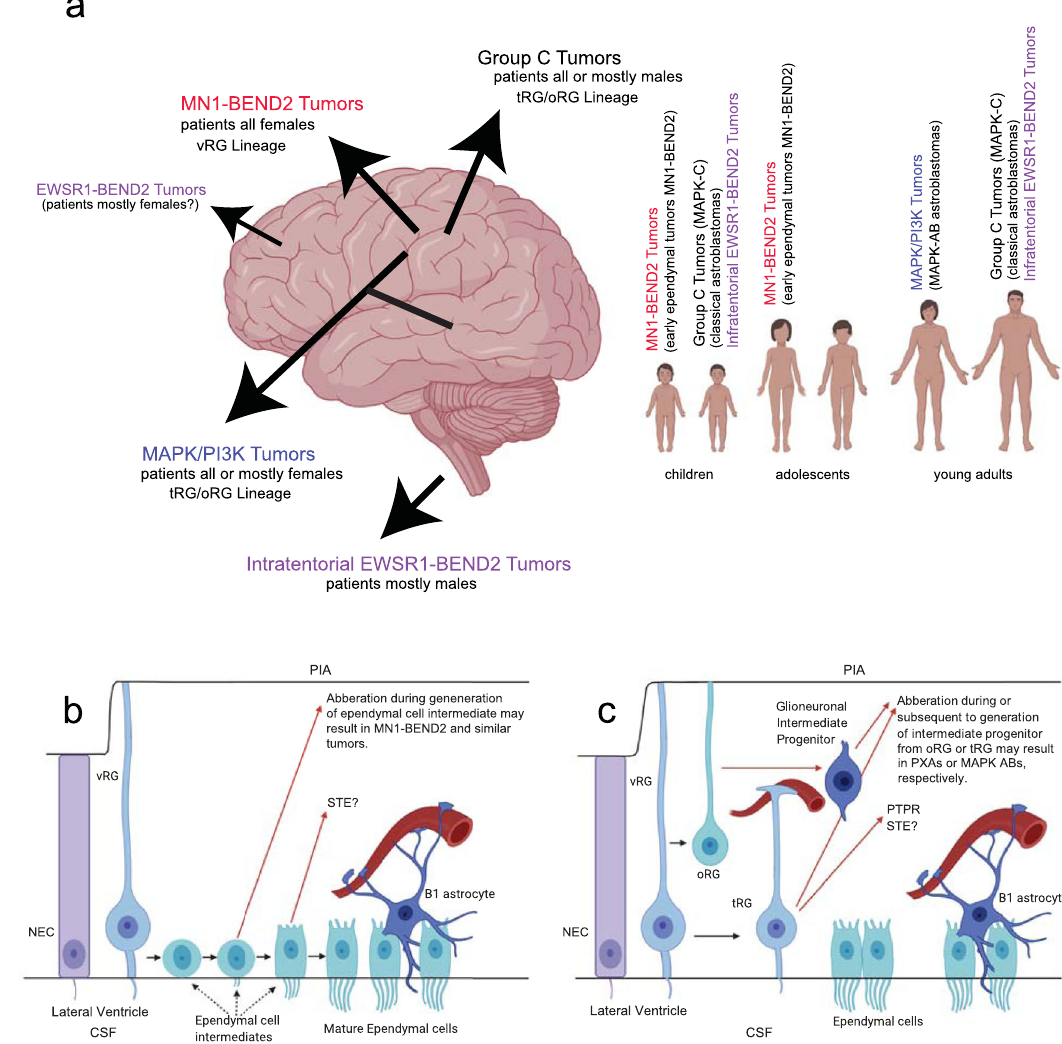
Fig. 8 Astroblastoma-like tumors show neural stem cell type-speci fi c transcriptional lineage of developmentaly early (vRG) to later (oRG and tRG) radial glia and clinically present in comensurate sequencial patient ages. a Summary of anatomic locations and patient age groups of molecular subtypes of AB-like tumors. b Hypothetical model for EET MN1-BEND2 tumorigenesis. c Hypothetical model for MAPK-ABC astroblastoma tumorigenesis. GSEA and RNA expression patterns of FOXJ1 and IGF2 suggest a temporal progression of early to late vRG to tRG and oRG genes and development of related tumor types: EET MN1-BEND2, FOXJ1 + / IGF2 + ; RELA STE, FOXJ1 + / IGF2 + ; PTPR, FOXJ1 + / IGF2 − ; MAPK-ABC and PXA, FOXJ1 − / IGF2